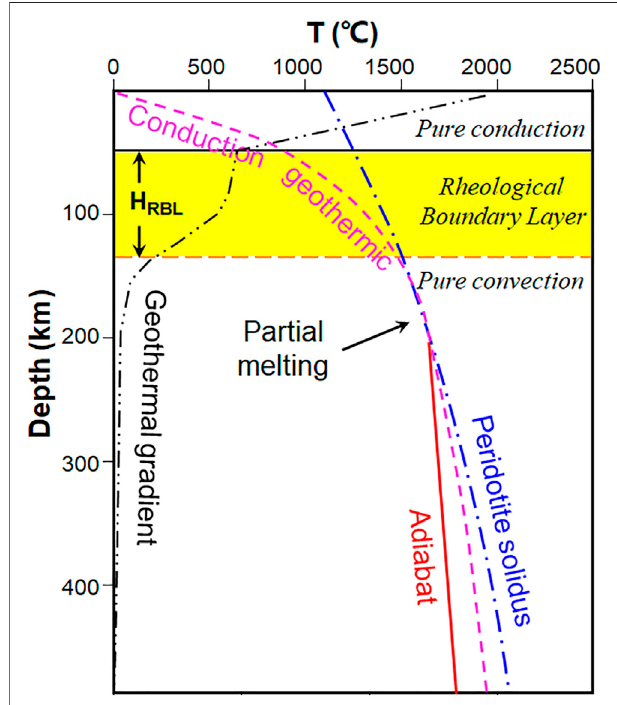
FIGURE 2 | Diagram of the crust – mantle thermal structure